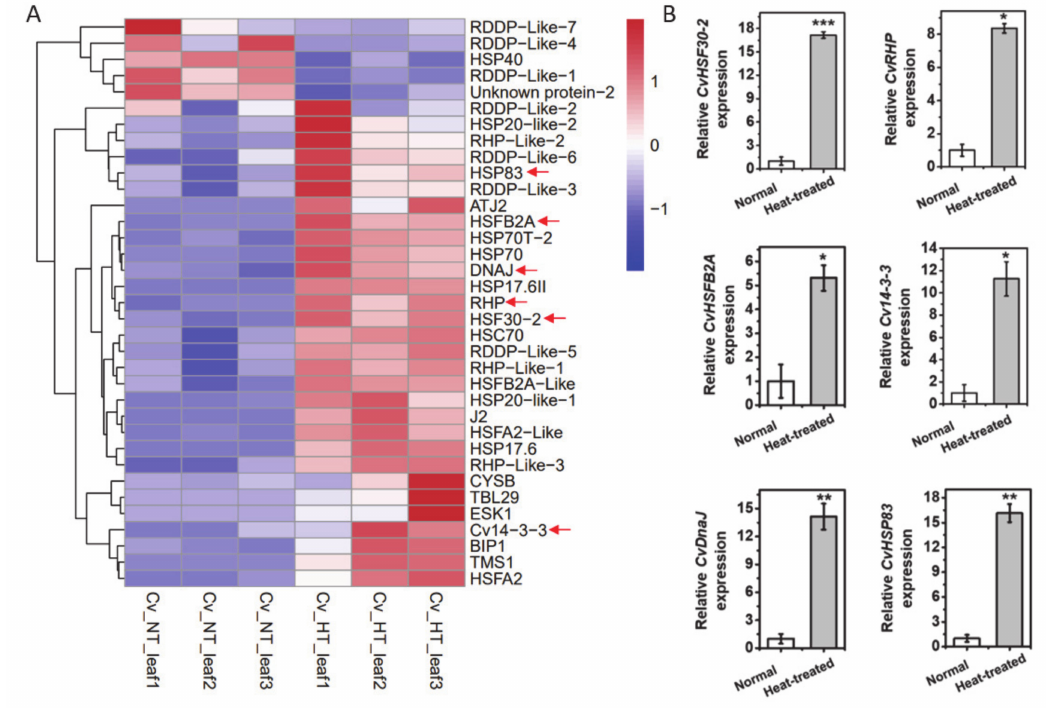
Figure 2. RNA-seq analysis of Clematis vitalba after high-temperature treatment. ( A ) Heat map of differentially expressing heat-related genes (HRGs). The genes chosen for the qPCR assay are marked by arrows. The descriptions of the names of HRGs are shown in Supplementary Table S2. ( B ) qPCR analysis of some HRGs. * p < 0.05; ** p < 0.01. *** p <